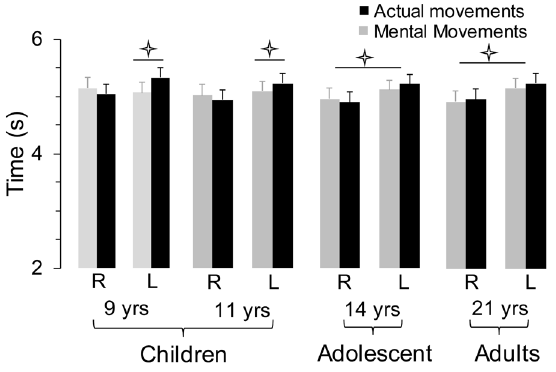
Figure 2. Average values ( + SE) of actual and imagined movement times are illustrated for the four age-groups and the two directions (L, left and R, right). Diamonds indicate significant differences between actual and mental movements. Stars indicate significant differences between right and left directions for both actual and mental